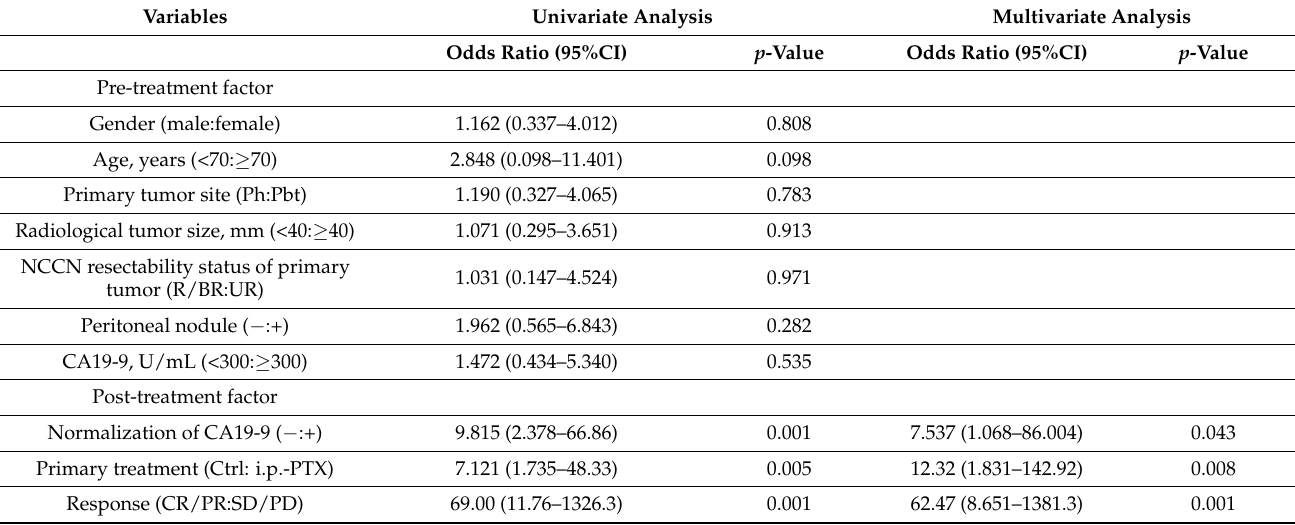
Table 3. Univariate and multivariate analysis to predict conversion